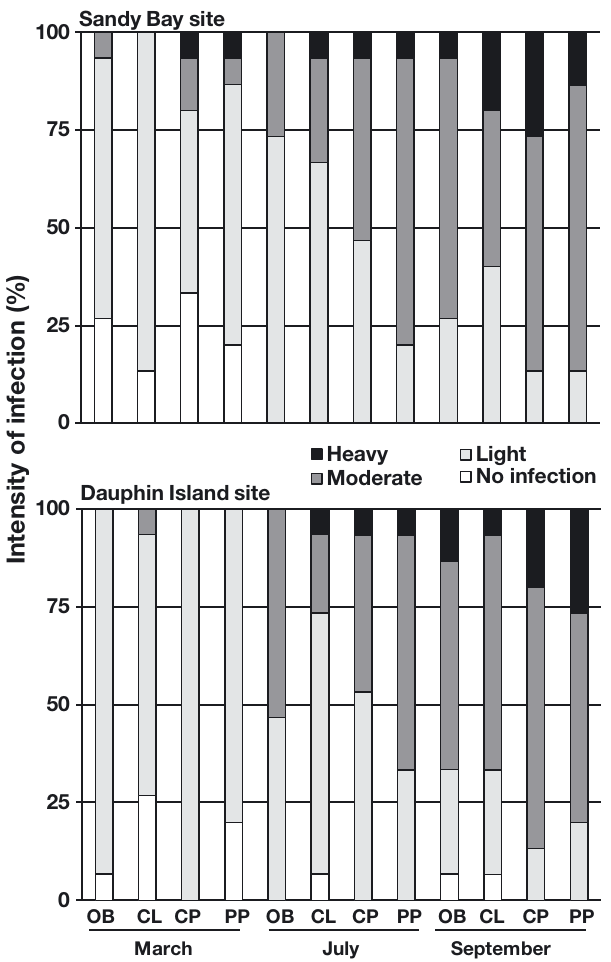
Fig. 8. Percentage of OBOY (OB), Calcasieu Lake (CL), Cedar Point (CP) and Perdido Pass (PP) oysters with no Perkinsus marinus infection and with light (<10 4 parasites g −1 wet tissue), moderate (1 × 10 4 to 5 × 10 5 parasites g −1 wet tissue) and heavy (> 5 × 10 5 parasites g −1 wet tissue) infec- tions sampled in March, July, and September 2012 at the Sandy Bay and Dauphin Island study